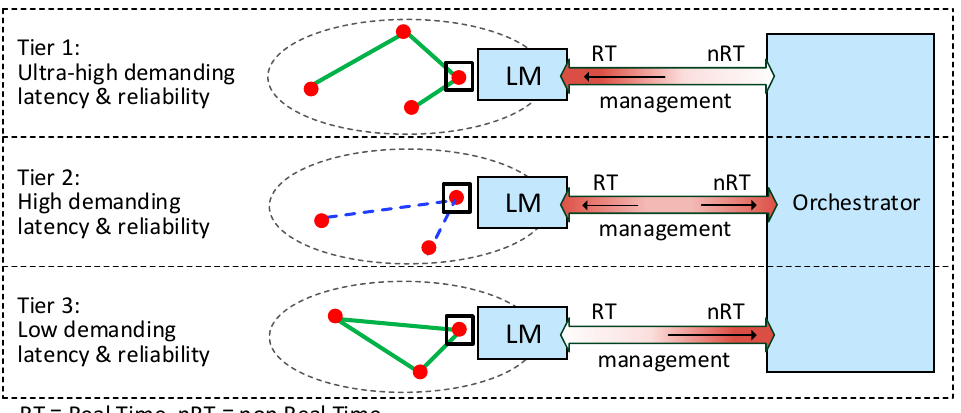
Figure 5. Local Manager (LM)–Orchestrator interaction at different tiers of the management architecture.